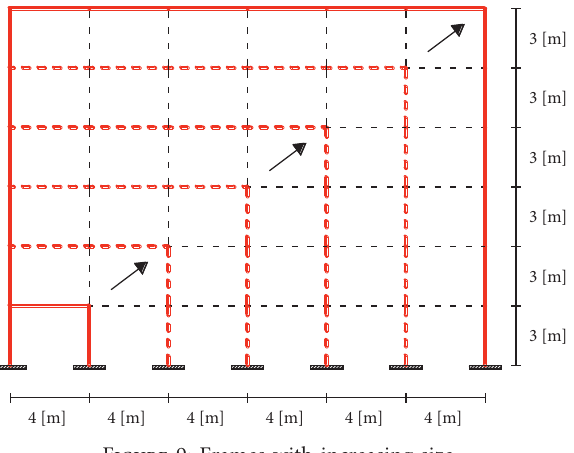
Figure 9: Frames with increasing size.